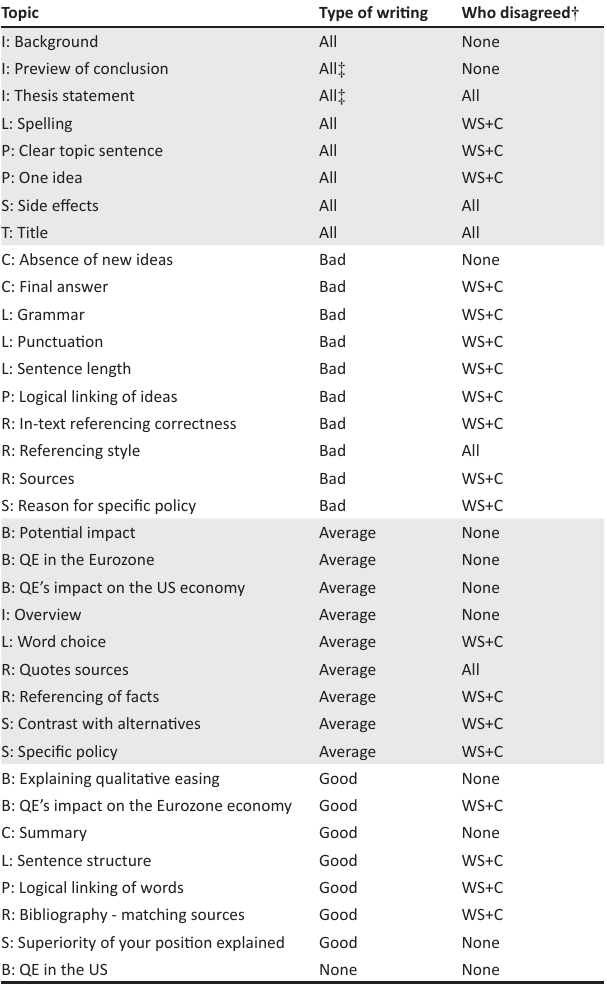
TABLE 3: Types of writing per topic where all evaluators had the most disagreements. Topic Type of